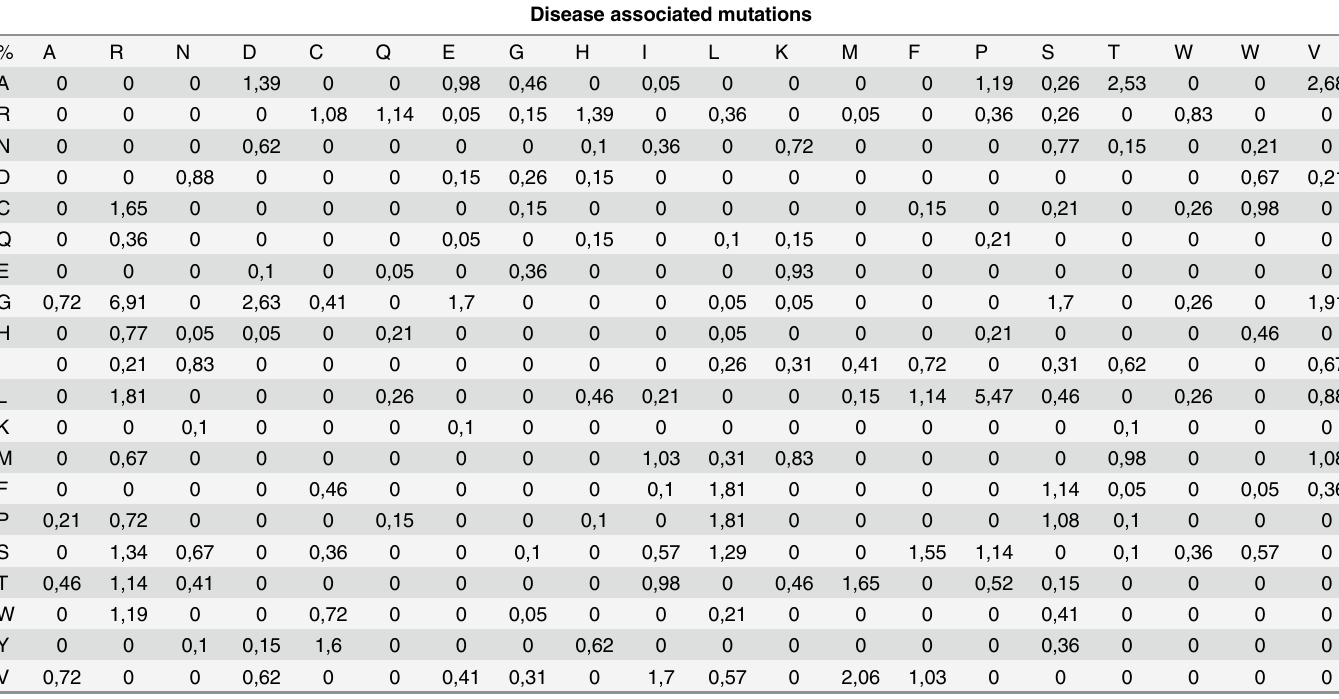
Table 4. Relative frequency of amino acid substitutions. Mutated amino acids are shown in rows; mutant amino acids are shown in columns associated with diseases. Disease associated